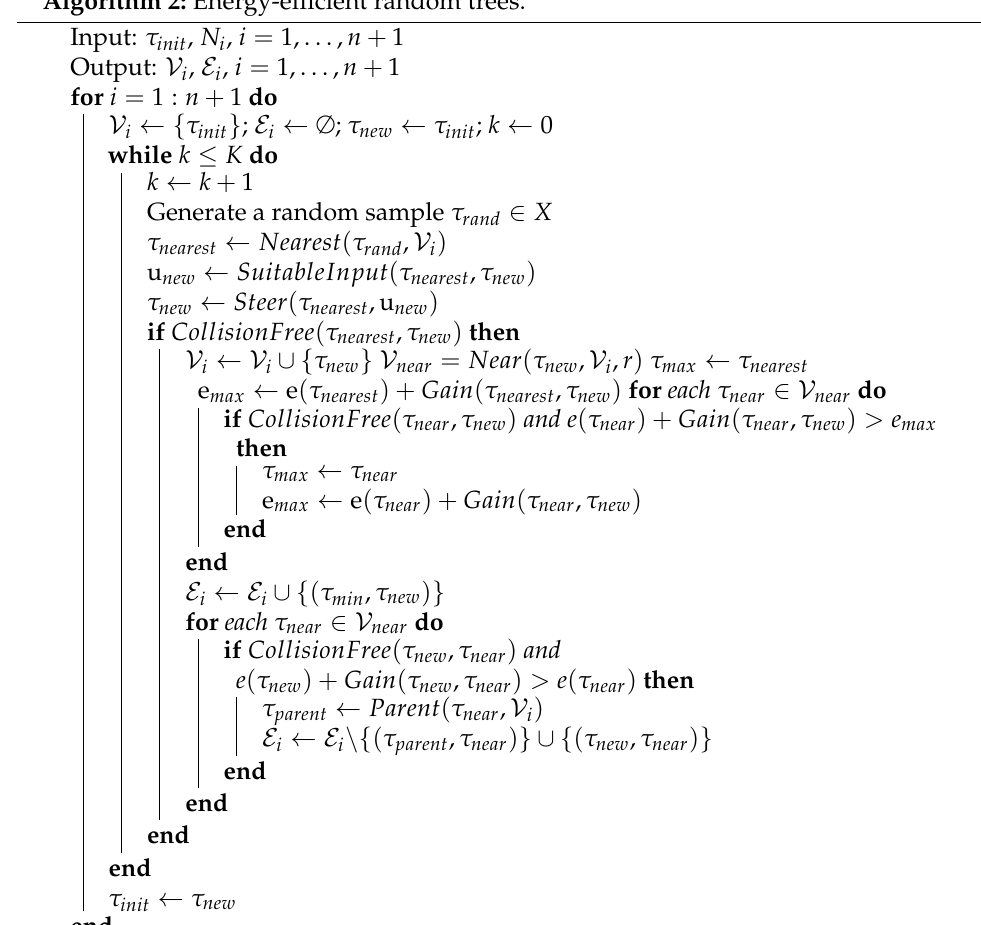
Algorithm 2: Energy-efficient random